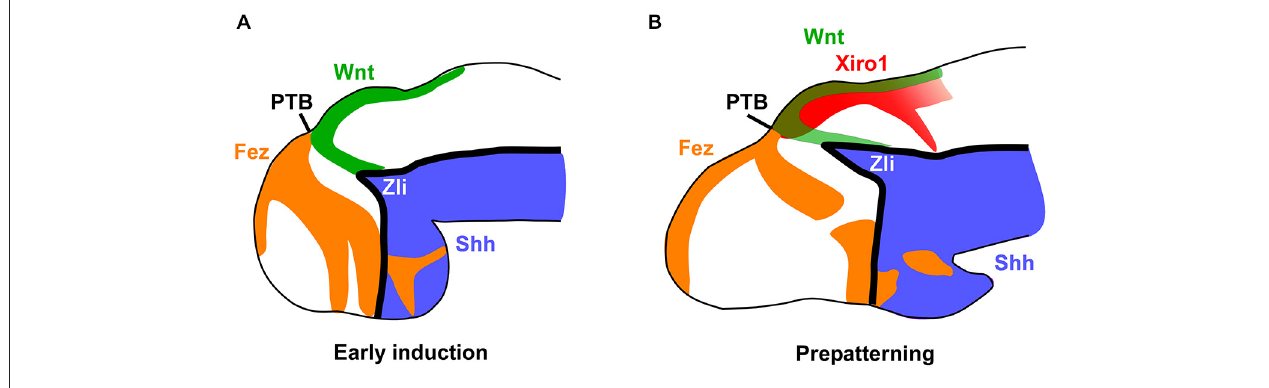
position of the Zli (A) , and the subsequent prepatterning of the thalamus and formation of the Zli (B) . The prethalamo-thalamic boundary (PTB) can be inferred in the zone where the rostral and caudal expressions abut.